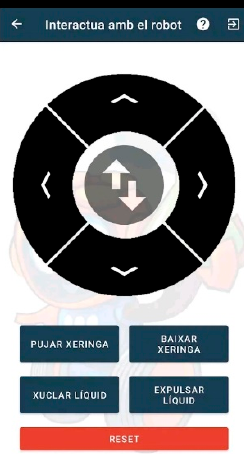
Figure 6. Interface for interacting with Lab Qui-Bot and Lab2 Qui-Bot.